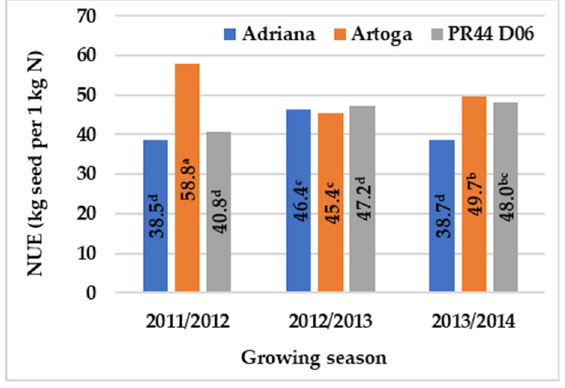
Figure 3. Nitrogen use efficiency of winter oilseed rape cultivars, across growing seasons (2011–2014). Means with the same letters do not differ significantly at p ≤ 0.05 in Tukey`s test. − 1 Regardless of cultivar, N rates higher than 180 kg ha exerted a yield-forming e ff ect only in − 1 combination with soil-applied S. In treatments supplied with high rates of N (180–230 kg N ha ), an increase in the N rate by 1 kg without supplementary S fertilization was not productive in any of the studied cultivars (Figure